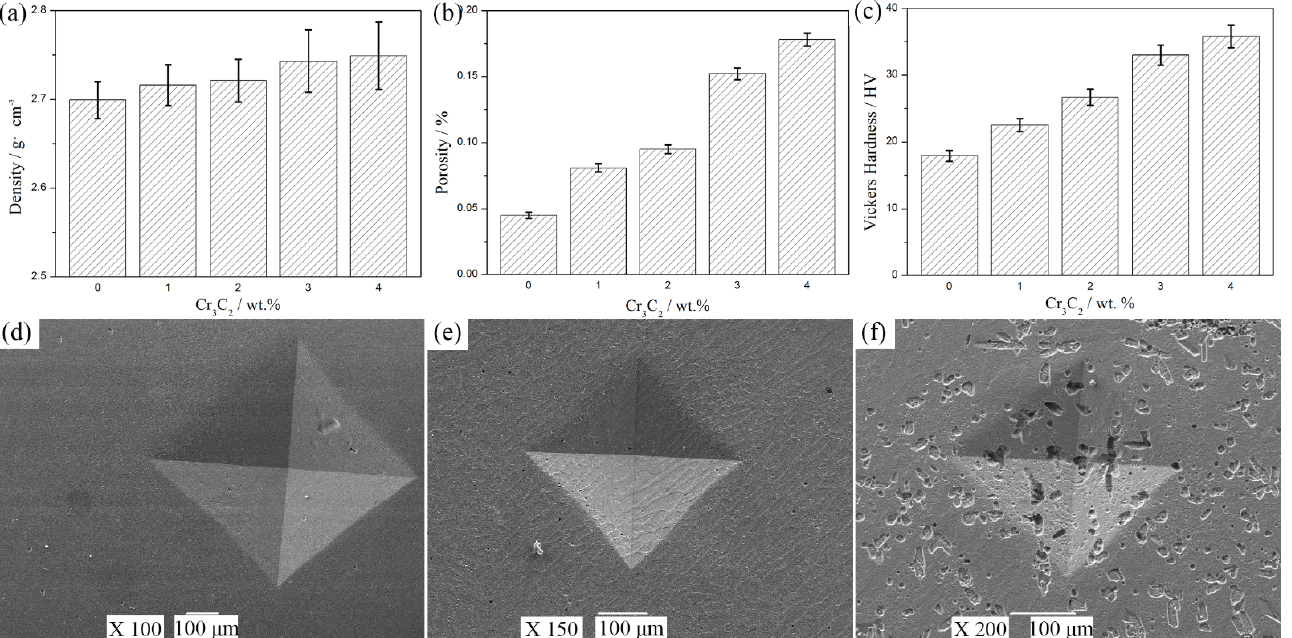
Figure 5. The mechanical properties and the indenter morphologies of the Cr 3 C 2 particle-reinforced Al matrix composite: ( a ) density, ( b ) porosity, ( c ) Vickers hardness, ( d ) pure Al, ( e ) 2.0 wt. % Cr 3 C 2p /Al composite, and ( f ) 4.0 wt. % Cr 3 C 2p /Al composite.